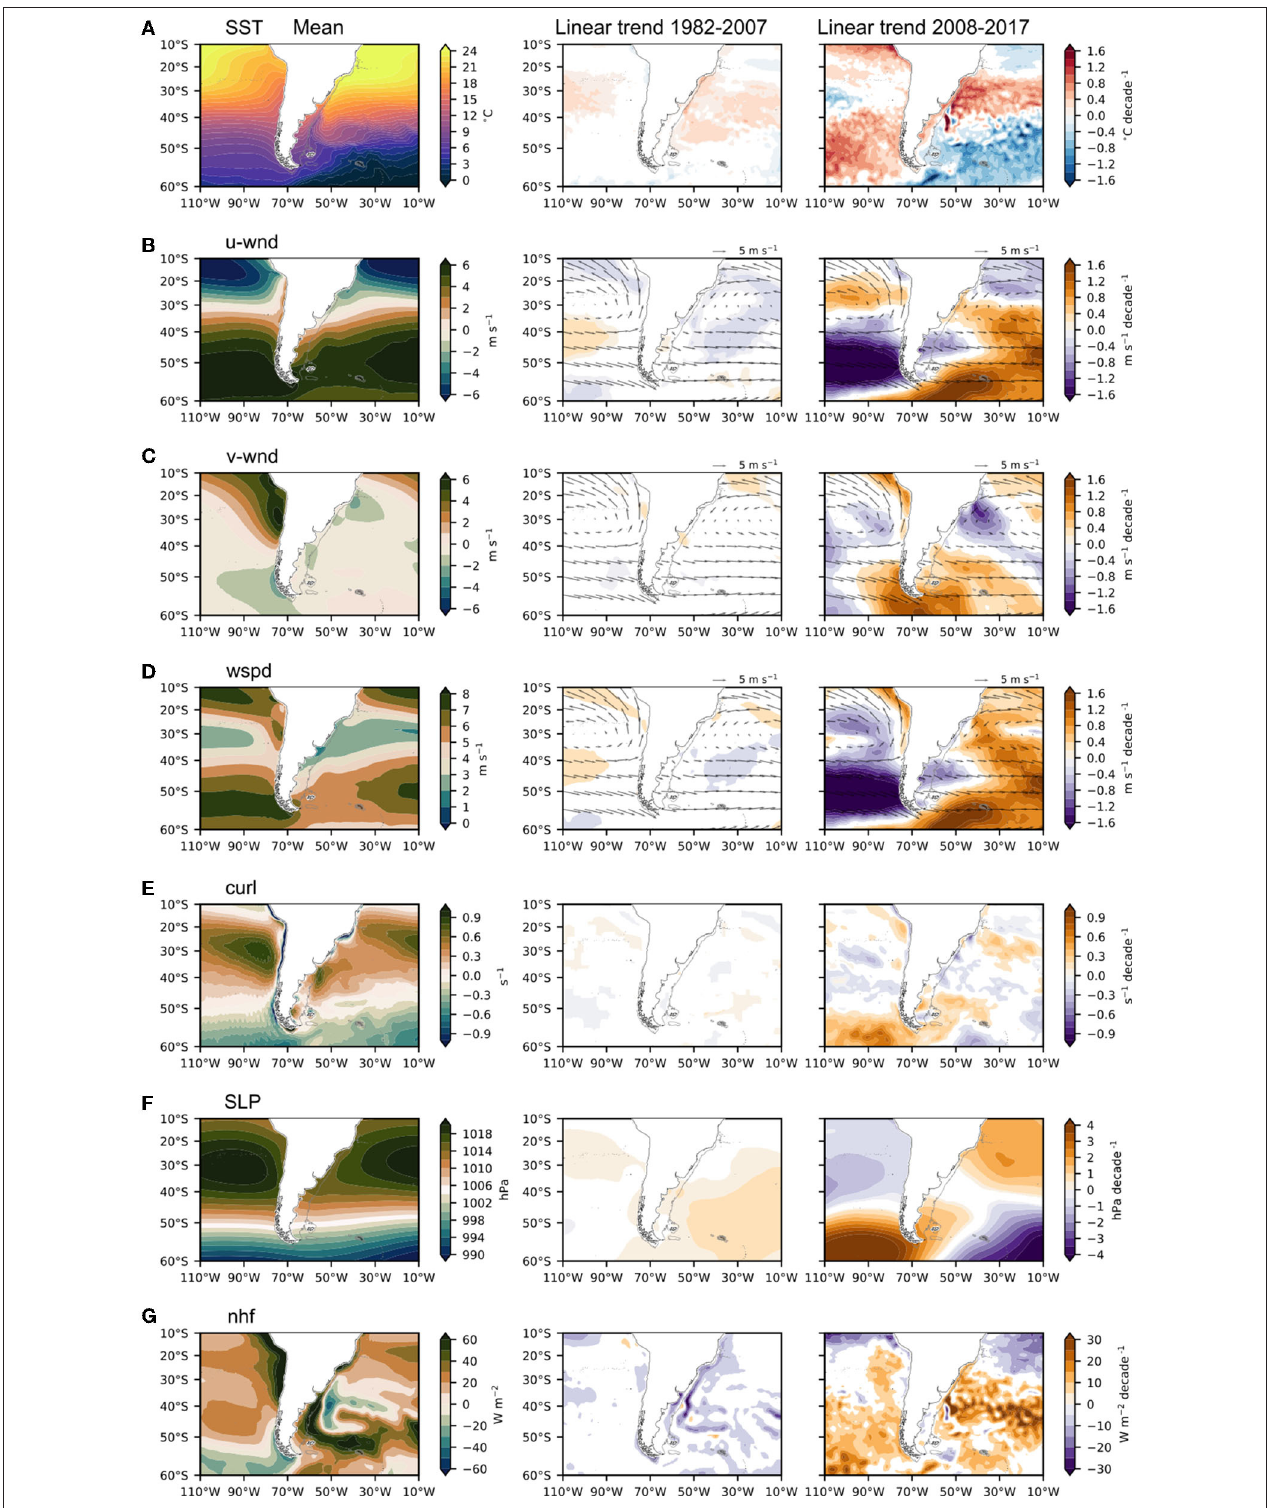
FIGURE 8 | (Left) Distribution of climatological (A) SST, (B) u-wnd, (C) v-wnd, (D) wind speed, (E) wind stress curl, (F) SLP, and (G) net heat flux for the 1982–2017 period. The wind speed, SLP and heat flux data are from Era-Interim (see Section 2.2). The spatial distribution of the linear trends of filtered anomalies of each variable are shown in the left panels (see Section 2.3 for methodology) calculated over 1982–2007 (center) and 2008–2017 period (right) (see details of selection of time periods in Section 3.2.2). Vectors in (B–D) show the distribution of climatological wind speed at 10 m height during 1982–2007 (center) and 2008–2017 (right) periods. Vectors are shown every 20 gridpoints. In every panel the 200 m isobath is also shown (solid gray line).